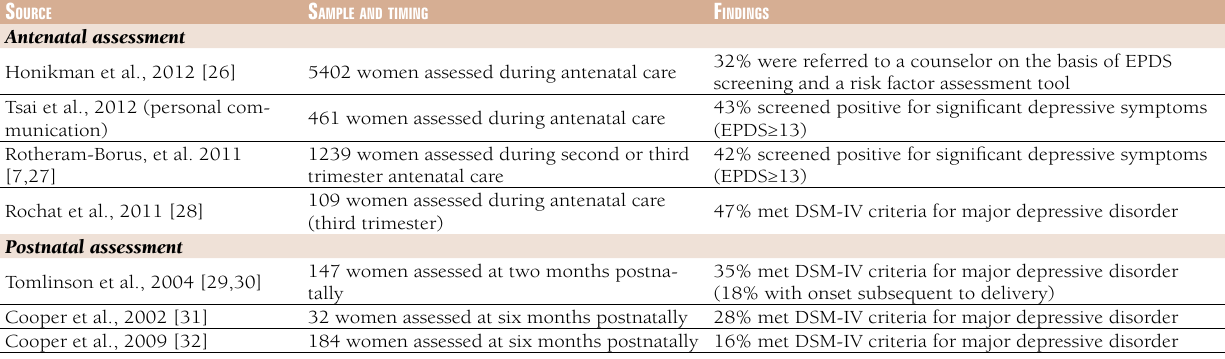
Table 1 Prevalence of perinatal depression in a peri-urban settlement near Cape Town S ource S ample and